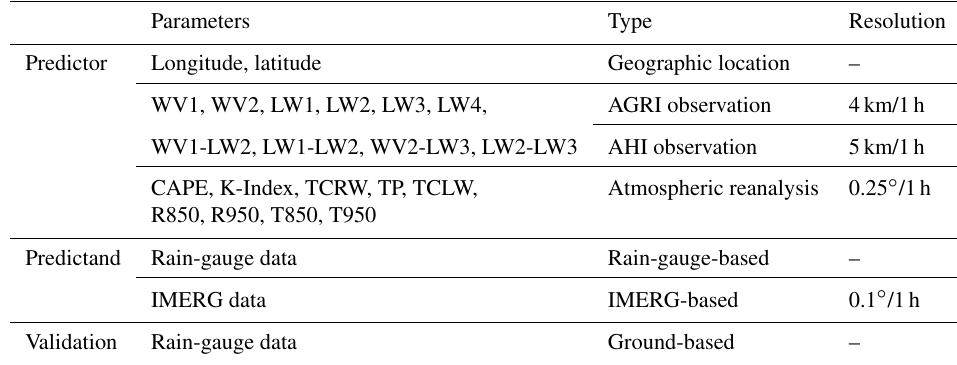
Table 4. Data and variables considered in this study for precipitation